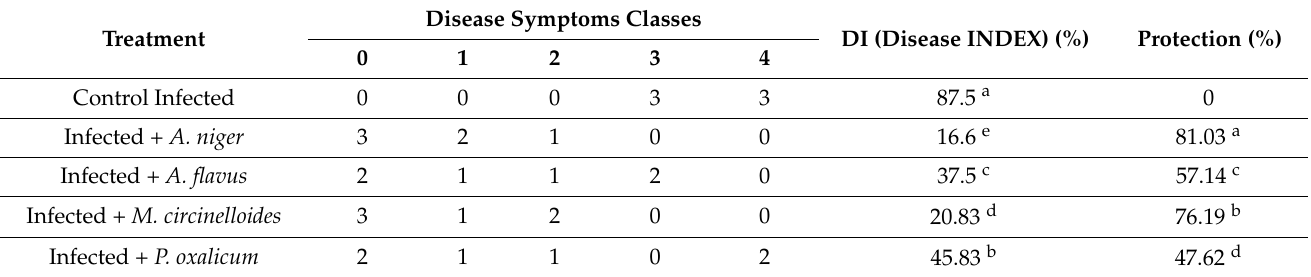
Table 1. Effect of PGPF on disease index of infected Tomato plants.